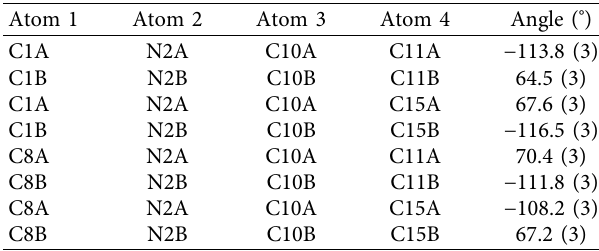
Table 5: Important torsion angles of the two independent mole- cules of the crystal structure 11 ( °